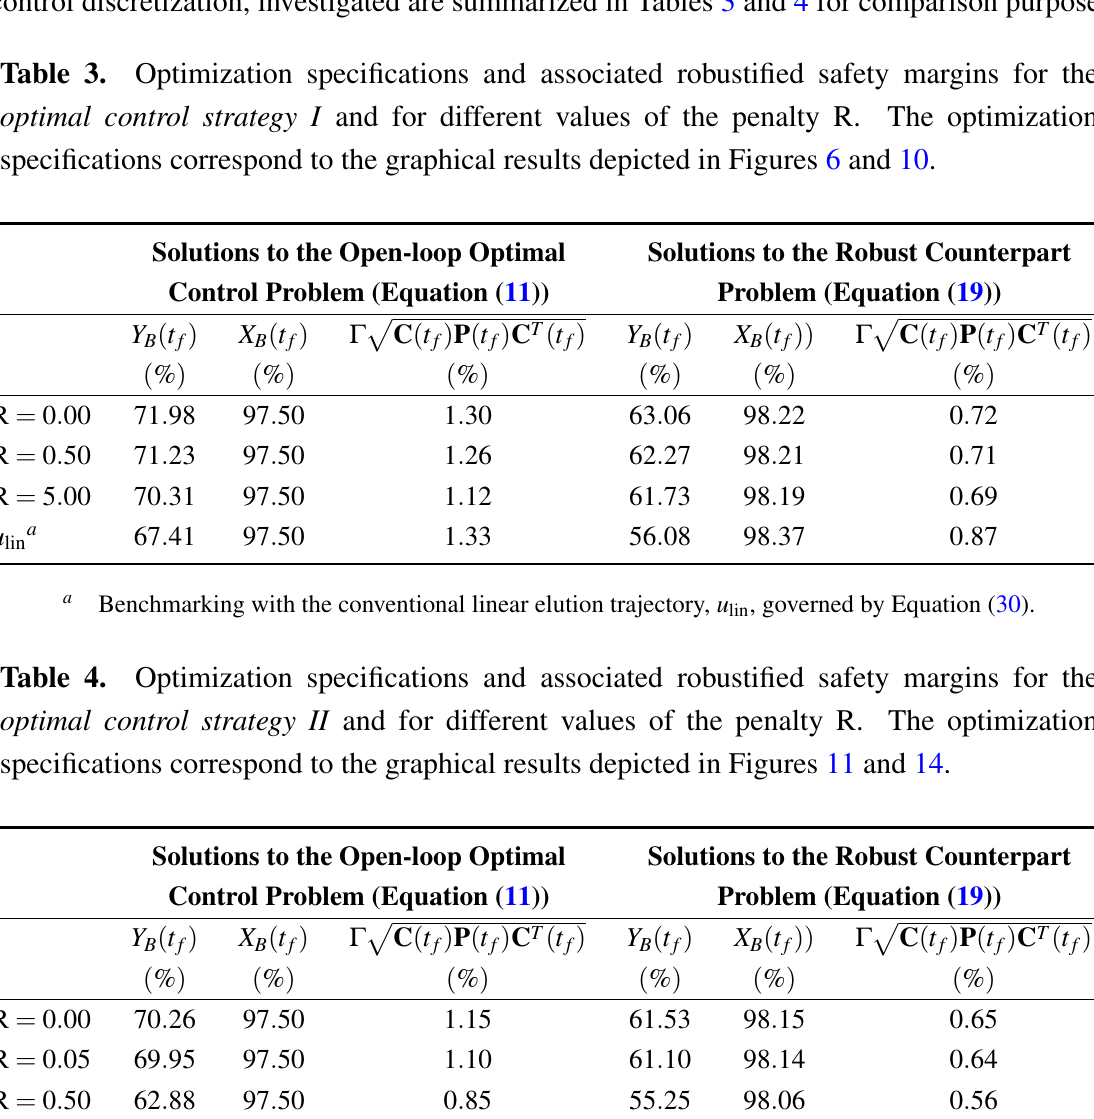
Optimization specifications and associated robustified safety margins for the optimal control strategy I and for different values of the penalty R. The optimization